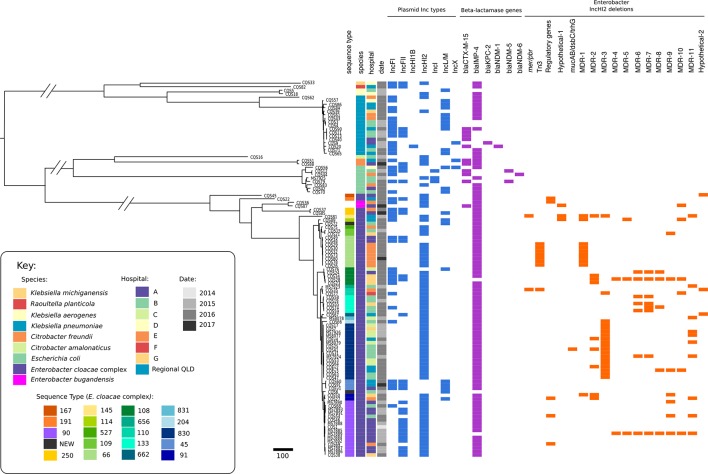
Phylogenetic tree of all isolates: the tree was built using 107 CPE collected between 2014 and 2017 using Parsnp v1.2 (default settings) against the reference genome MS7884 (GenBank: CP022532.1). Plasmid types and resistance genes shown here are a selection of the most prevalent types. The majority of isolates were found to be part of the 
E. cloacae
 complex, with a high prevalence of bla
IMP-4 and IncHI2 plasmid types. Orange blocks represent missing plasmid regions identified by comparison of IncHI2 + 
Enterobacter
 isolates to the IncHI2 plasmid pMS7884A using BRIG (see Fig. S7 and Supplementary Data).